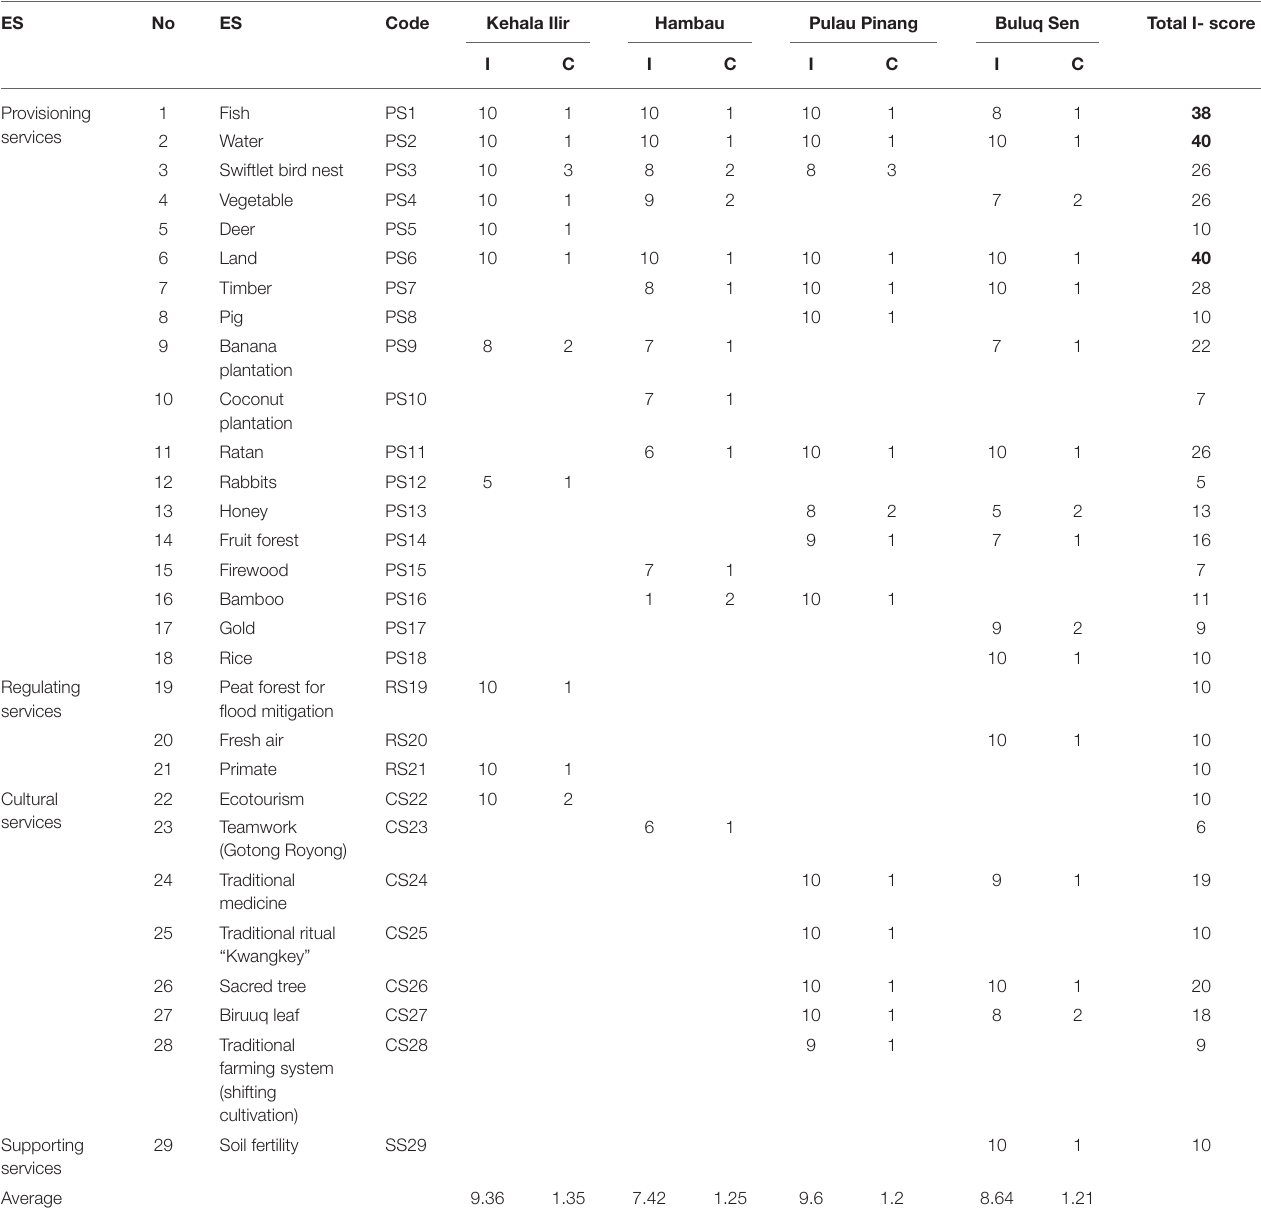
TABLE 3 | Ecosystem services perceived by local communities.